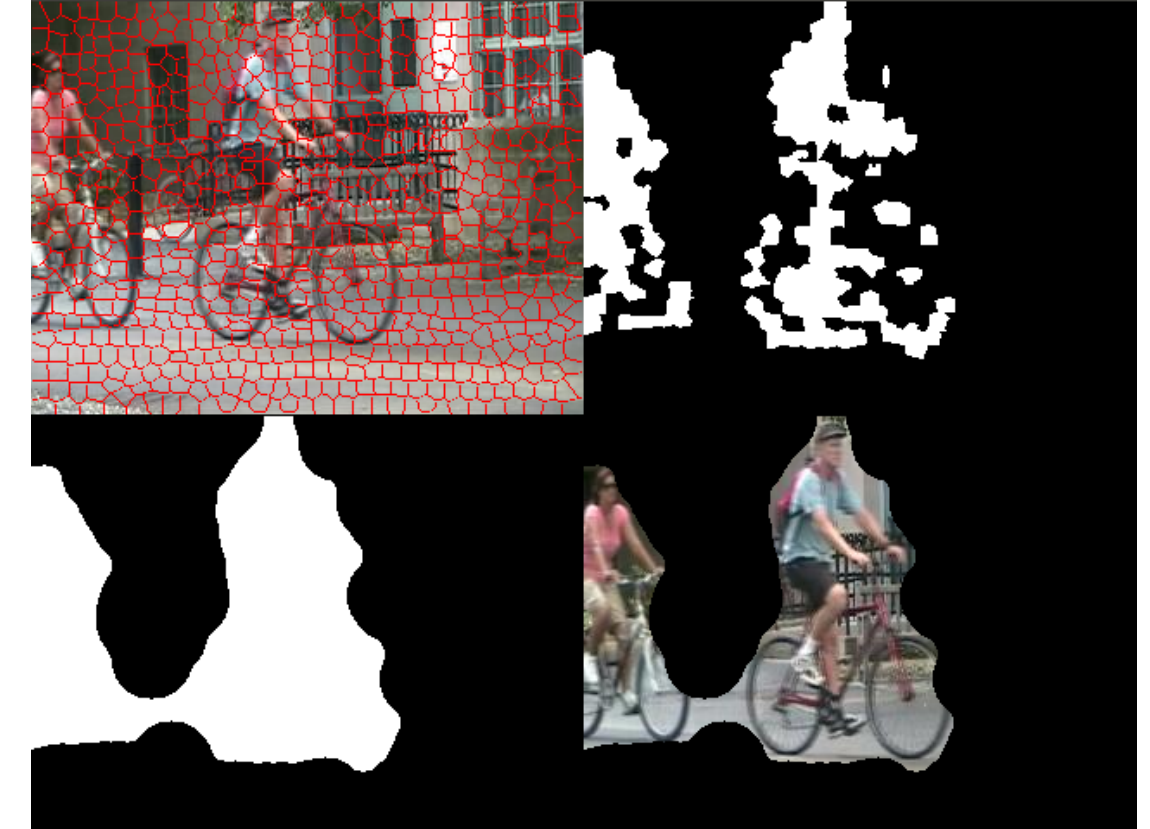
Figure 2. SuperBE on the CDW2014 backdoor sequence, showing the superpixel segmentation (top-left ), the output mask without ( top-right ) and with ( bottom-left ) post-processing, and then with the mask applied to the original image ( bottom-right